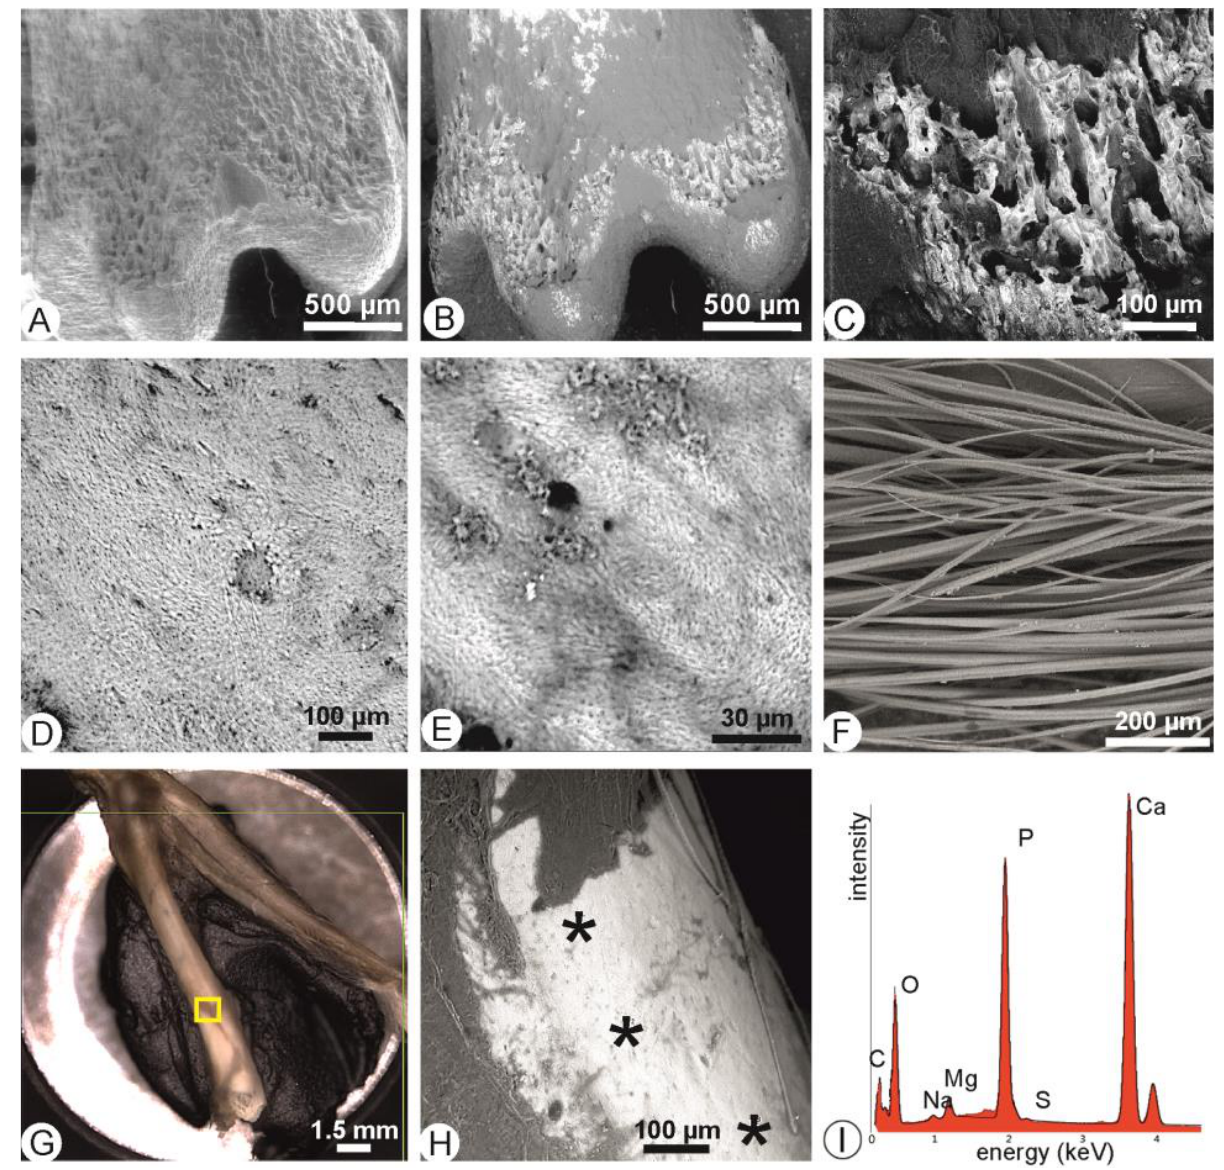
Figure 5. Lipase etching. ( A , B ). SE ( A ) and BSE ( B ) images of the extremity of a femur of Apodemus showing the presence of organic remains. ( C ). Cancellous structure rich in organic matrix; BSE im- age. ( D – E ). Haversian structure visible in clean zones of the scapula of Apodemus . ( F ). Hairs are not etched in the same sample. ( G ). Optical image showing clean pale yellow bone, and brown zones with flesh are brown. ( H ). Localization of electron microprobe spectra: stars ( I ). Spectra show that P and Ca are present as well as Na, Mg and